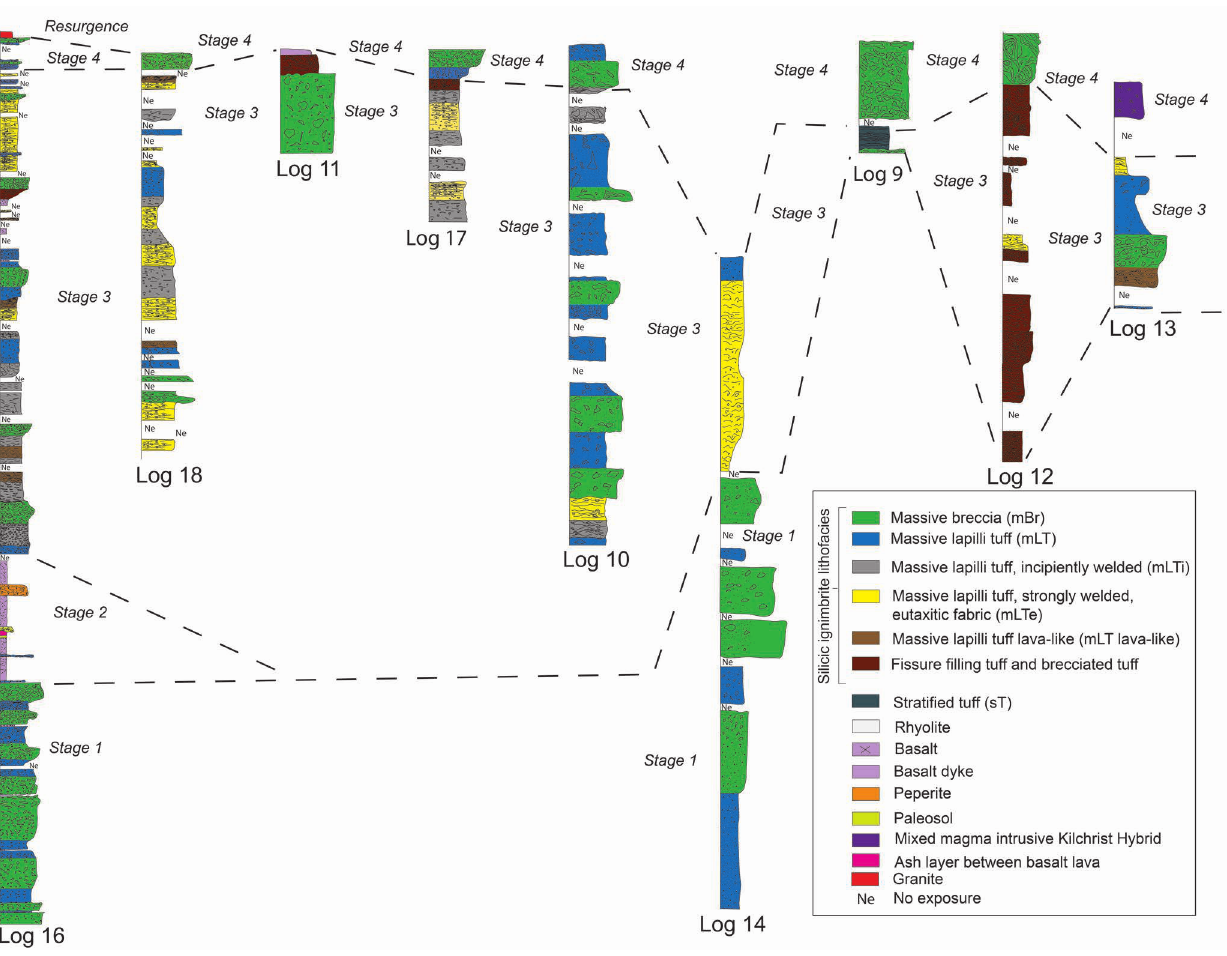
Figure 12: Correlation of logged sections (south). Proposed KVF eruption stages interpreted by correlation of logs 9–14 and 16–18 to the South of Beinn Dearg Bheag (Figure 3). Generalised vertical scale shown may be reduced in regions of no exposure (for details of vertical scale within individual logs 9–14 and 16–18 refer to supplementary file (logs B). (Figure 3). Randomly orientated fault traces (typically ~1 km in length), surround the Beinn na Caillich Granite and cut coun- try rock within the caldera outer marginal zone (Figure